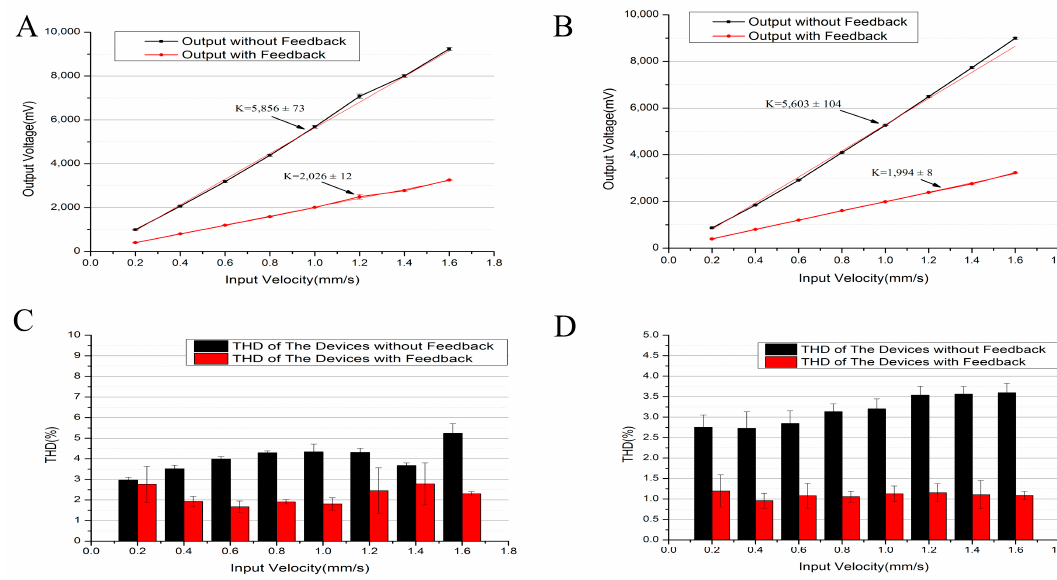
Figure 7. ( A , B ) The sensitivity of the MEMS electrochemical seismic sensors with and without feedbacks as a function of input velocities at 1 Hz and 5 Hz, respectively. ( C , D ) Total harmonic distortions of the MEMS electrochemical seismic sensors with and without feedbacks as a function of input velocities at 1 Hz and 5 Hz, respectively.